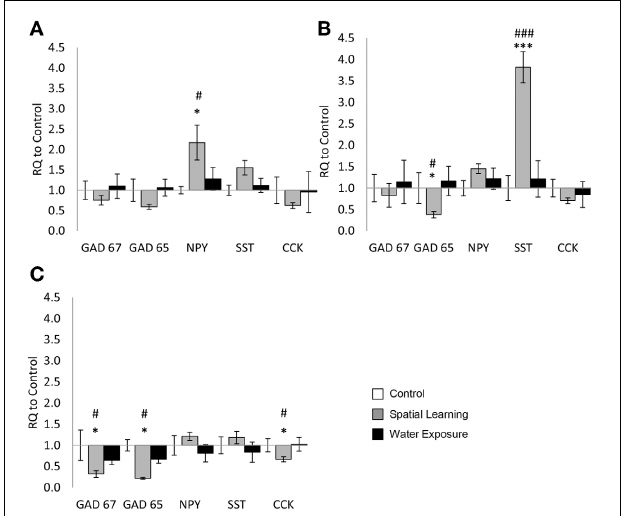
FIGURE 1 | Highly selective change of GABAergic gene expression in the hippocampus. Differential mRNA expression changes of the selected GABAergic marker genes GAD65 and GAD67 as well as the neuropeptides neuropeptide Y ( NPY ), somatostatin ( SST ), and cholecystokinin ( CCK ) were observed in distinct hippocampal subregions 5h after spatial learning utilizing an invisible platform vs. water exposure only. (A) In the hilus of the dentate gyrus NPY mRNA expression levels were increased in the Spatial Learning group. No significant differences between the groups were observed in other genes. (B) In the stratum oriens of the CA3 subregion GAD65 mRNA levels were decreased as well in the Spatial Learning group, while SST expression was increased. (C) In the stratum oriens of the CA1 subregion, GAD65 , GAD67 , and CCK mRNA expression levels were decreased in the Spatial Learning group. Values are shown as relative quantification to handled controls [RQ; RQ ( Control ) = 1] and mean ± s.e.m. per group. ∗ Significant difference from Control with p < 0 . 05; ∗∗∗ p < 0 . 001; # significant difference between Spatial Learning and Water Exposure groups with p < 0 . 05; ### p < 0 .